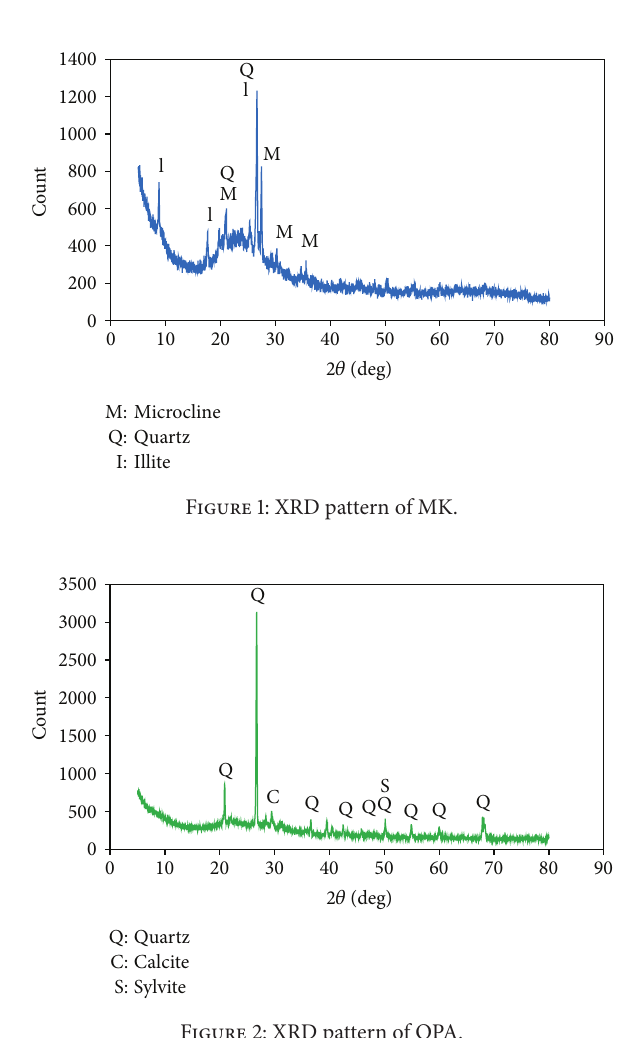
Figure 2: XRD pattern of